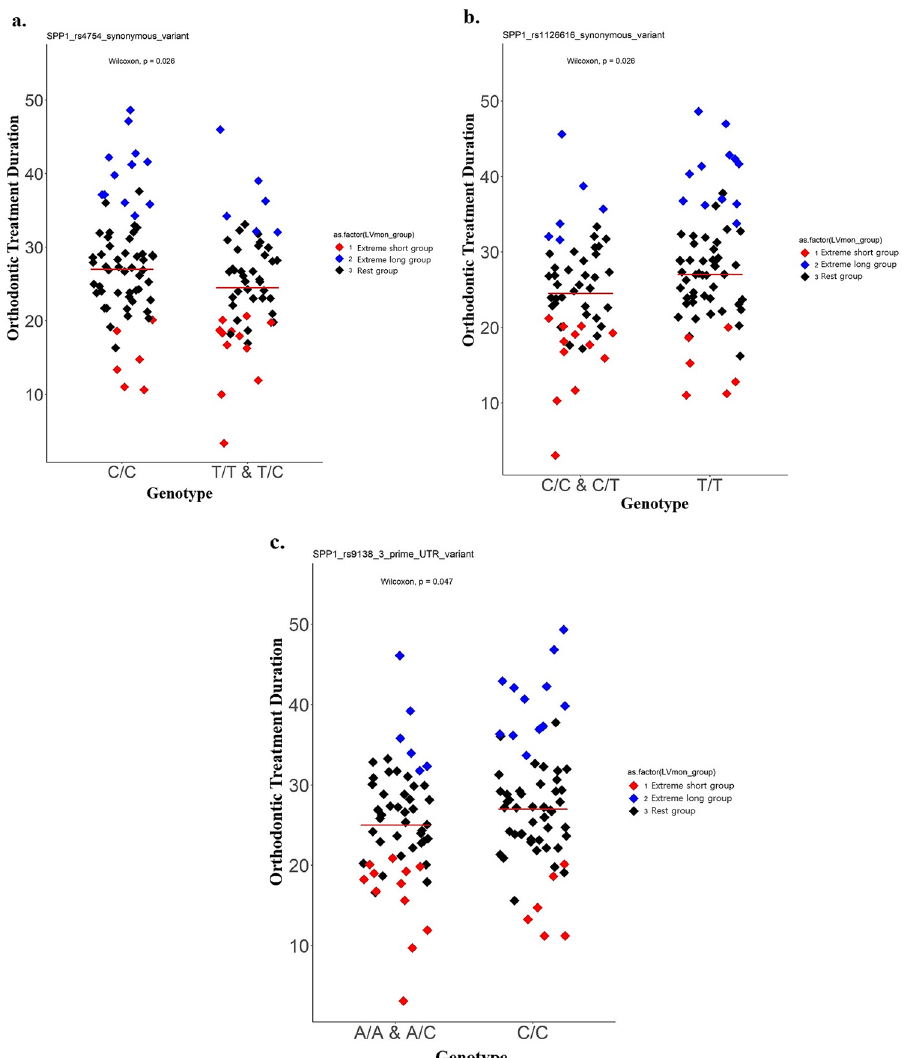
Figure 1. Orthodontic treatment duration according to genotypes in SNPs of SPP1. ( a ) SPP1 (rs4754), ( b ) SPP1 (rs1126616), ( c ) SPP1 (rs9138), A scatter plot illustrating the orthodontic treatment duration in each genotype. The y-axis represents the orthodontic treatment duration values (months) and horizontal bars in the scatter plots represent mean values. Statistical analysis was performed with the Wilcoxon test. *P <